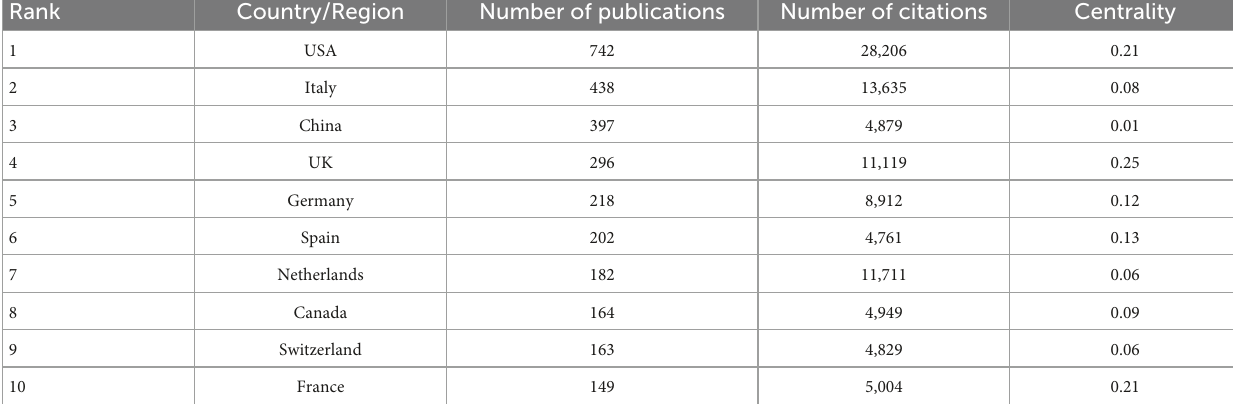
TABLE 2 Top 10 prolific institutes from